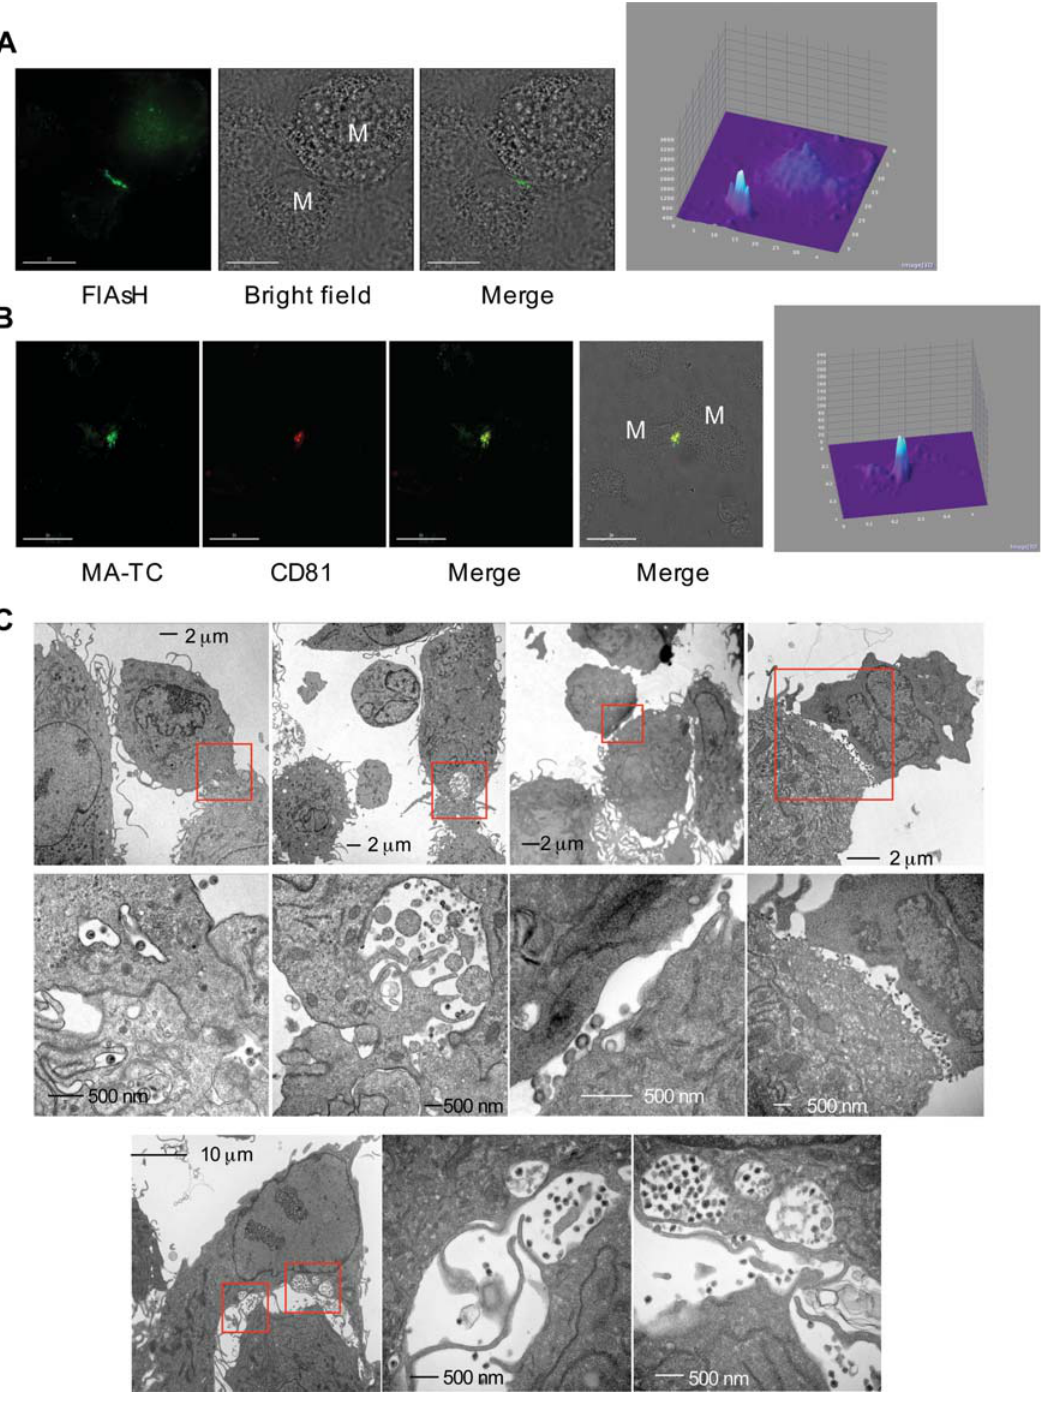
Figure 5. Gag accumulates at the MDM/MDM synapse. Cells were infected with VSV-G-pseudotyped NL4-3/MA-TC virus, labeled with FlAsH 24–48 hrs post-infection, and fixed in 3.7% formaldehyde. (A) Gag accumulates at the synapse between MDMs. Individual macrophages are labeled ‘‘M’’. Scale bar=15 m m. (B) After FlAsH labeling, cells were fixed and stained with anti-CD81 antibody. The extensive overlap between Gag and CD81 at the MDM/MDM synapse is visualized as yellow in the merged panels. Scale bar=30 m m. Far-right panels in (A and B) provide quantification of the Gag signals. The Surface Plot analyzing tool from the ImageJ software was used to obtain a three-dimensional graph of the pixel intensities in grayscale. The x- and y- axes represent the length of the region analyzed in pixels, and the z-axis represents the pixel intensity of the Gag signal. (C) EM analysis of VLPs at the synapse. Infected MDMs were fixed with 2% glutaraldehyde and processed for EM. Fully assembled VLPs can be visualized at the MDM/MDM junctions. Red boxes represent regions that are enlarged in the adjacent panels.